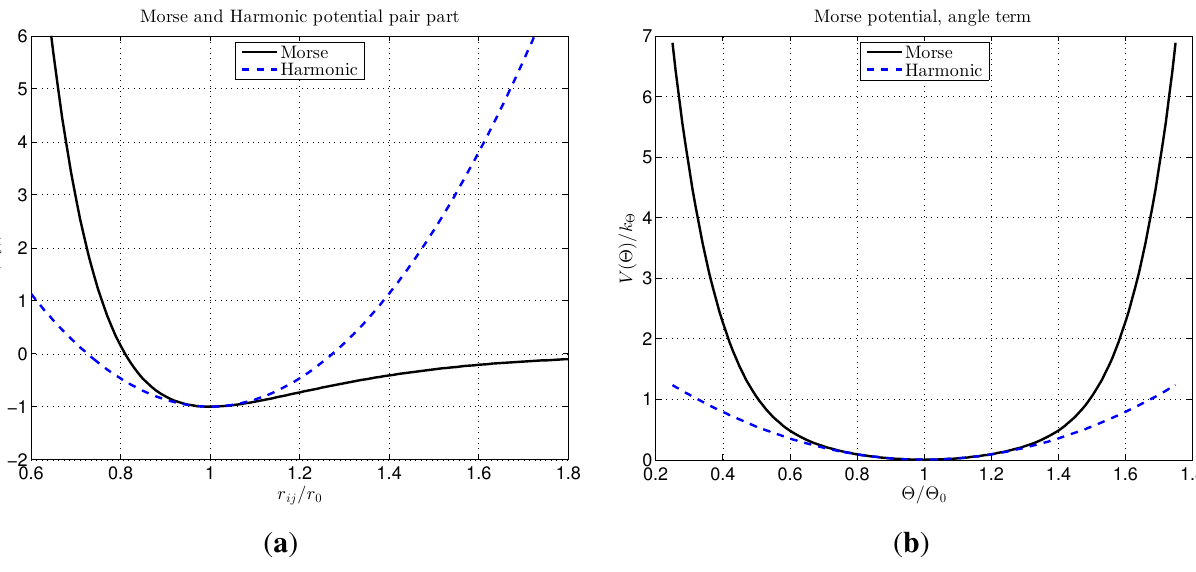
Figure 1. Distribution of the Morse potential and equivalent harmonic potential for the pair part ( a ) and for the angular part ( b